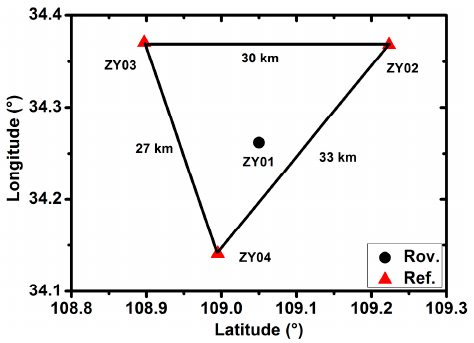
Figure 2. The distribution of the collected reference and rover stations (The reference stations are shown in red, and the rover station is shown in black).